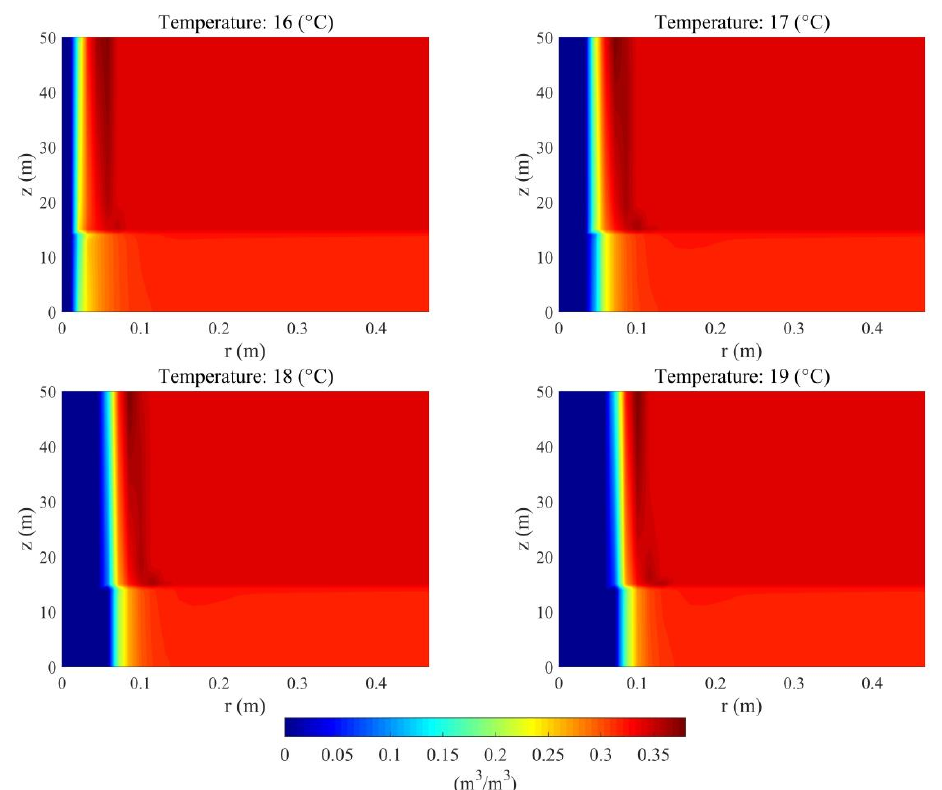
Figure 8. Comparison of two-dimensional hydrate saturation distribution of hydrate reservoirs for a fixed salinity of 3.05 wt% at the 24th hour of drilling fluid invasion under different drilling fluid temperatures.